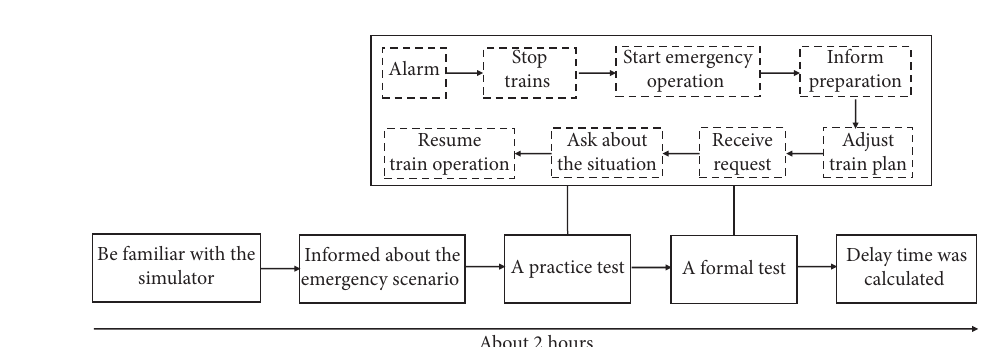
Figure 5: The procedures of the simulator test.